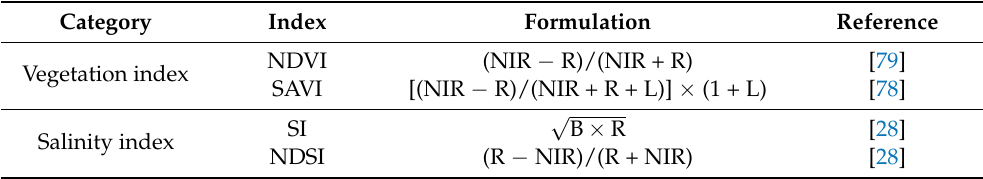
Table 3. Vegetation and soil salinity indexes for soil salinity assessments. Category Index